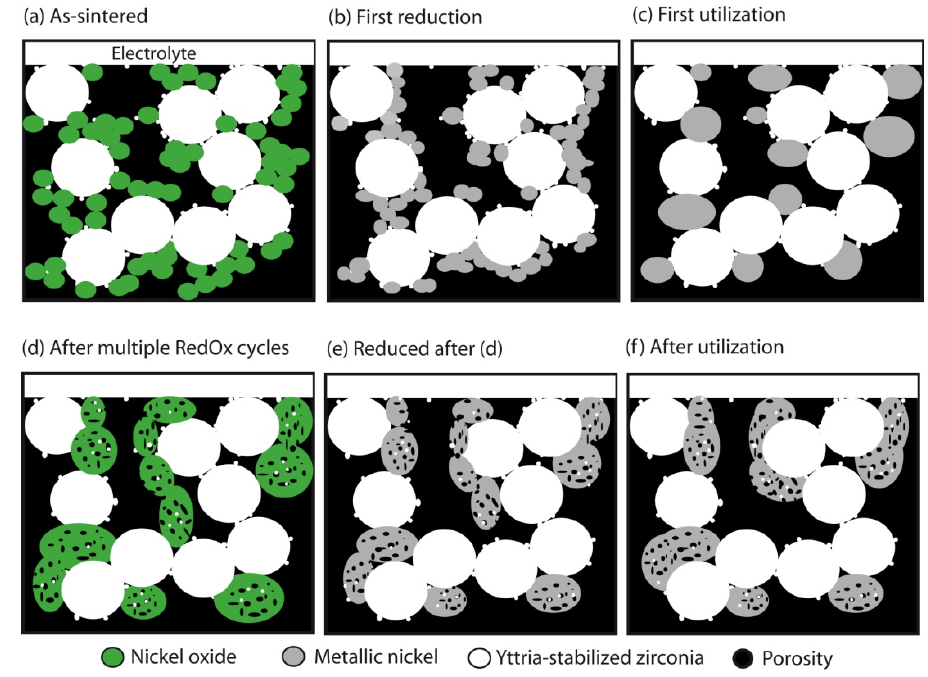
Figure 36. Scheme of RedOx behavior of highly porous Ni-YSZ anode supported half-cell [129].